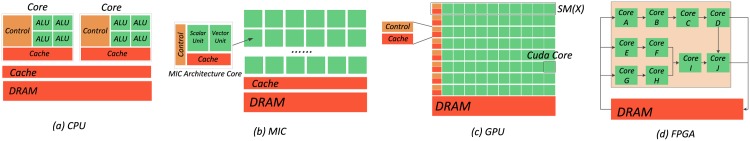
The hardware architecture of the multi-core CPU, MIC, many-core GPU, and reconfigurable FPGA.